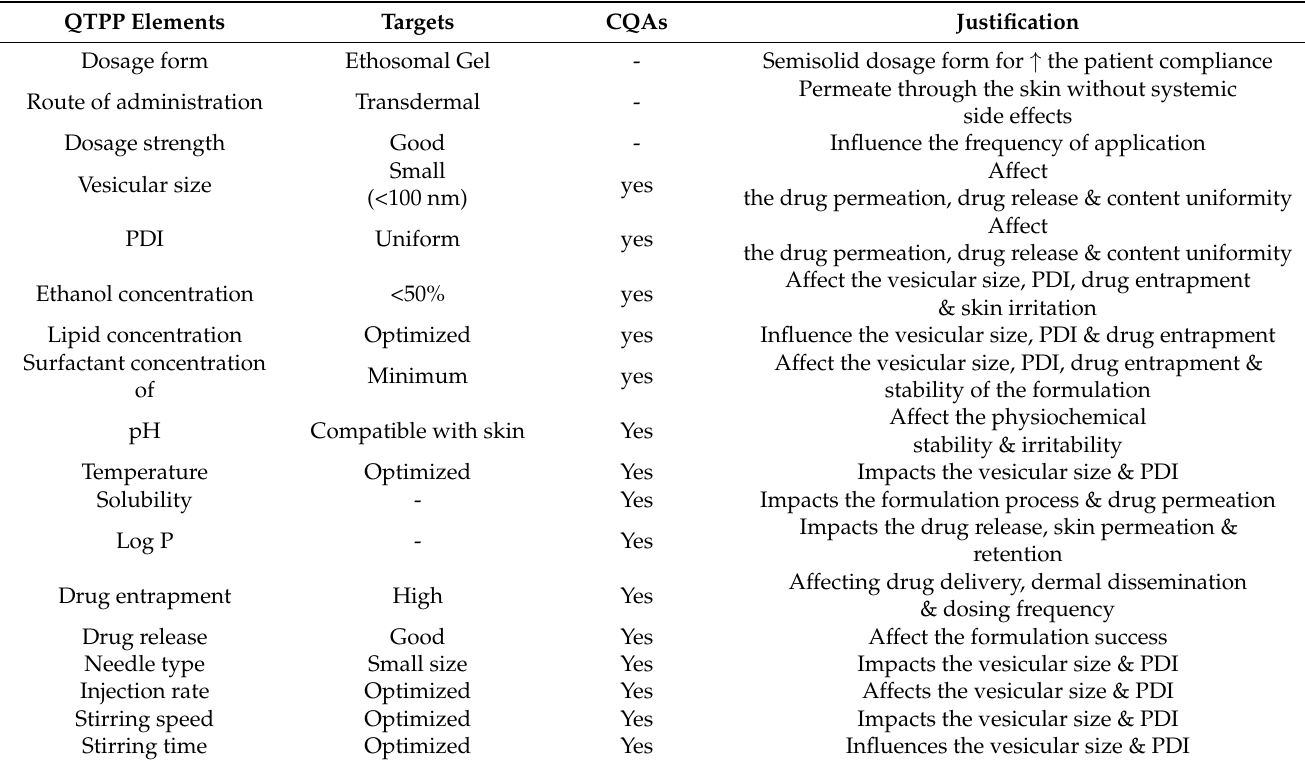
Table 1. Elements of quality target product profile for ethosomal gel. The targets and justification are discussed for each quality target product profile element along with the identification of critical quality attributes. It specifies the desired quality standards of the